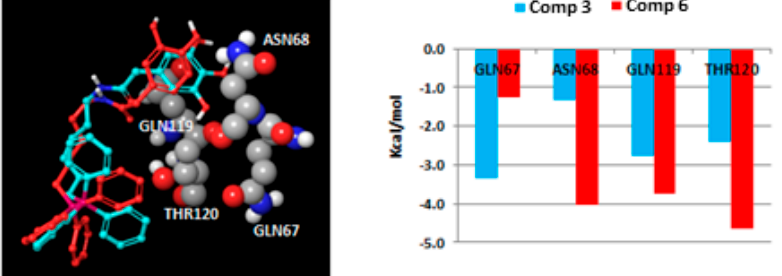
Figure 4. Coulomb and van der Waals interactions between the hydroxyphenyl framework of Com- pounds 3 and 6 and the BChE residues.